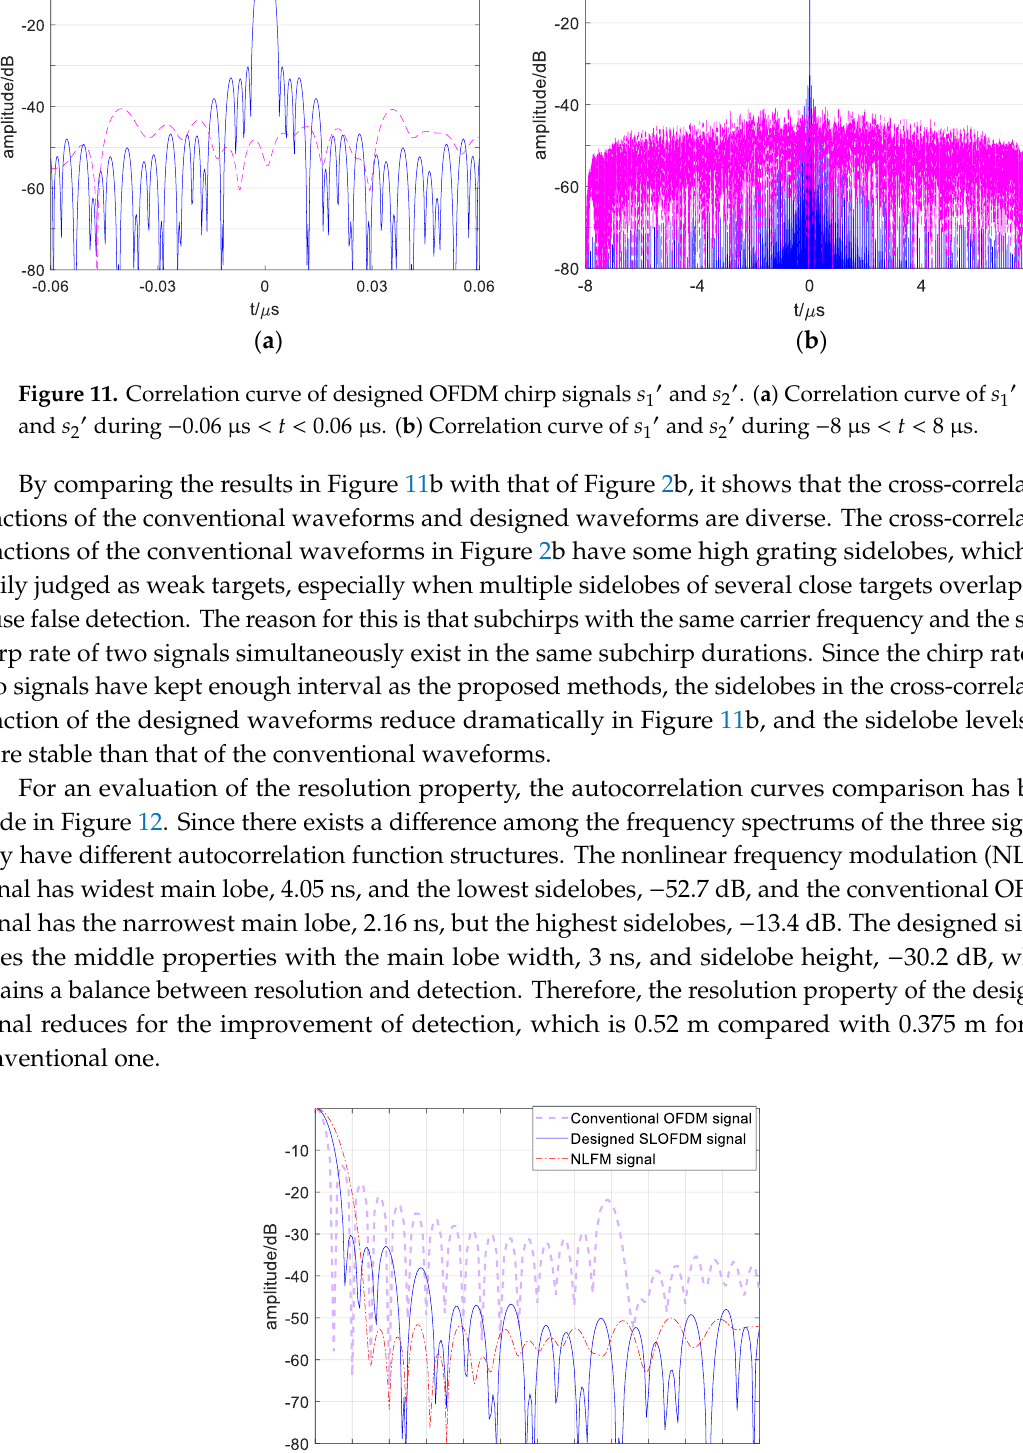
Figure 12. Autocorrelation curve comparison among designed OFDM chirp signals s 1 (cid:48) , conventional signal s 1 , and nonlinear frequency modulation (NLFM) signal during 0 < t < 0.06 µ